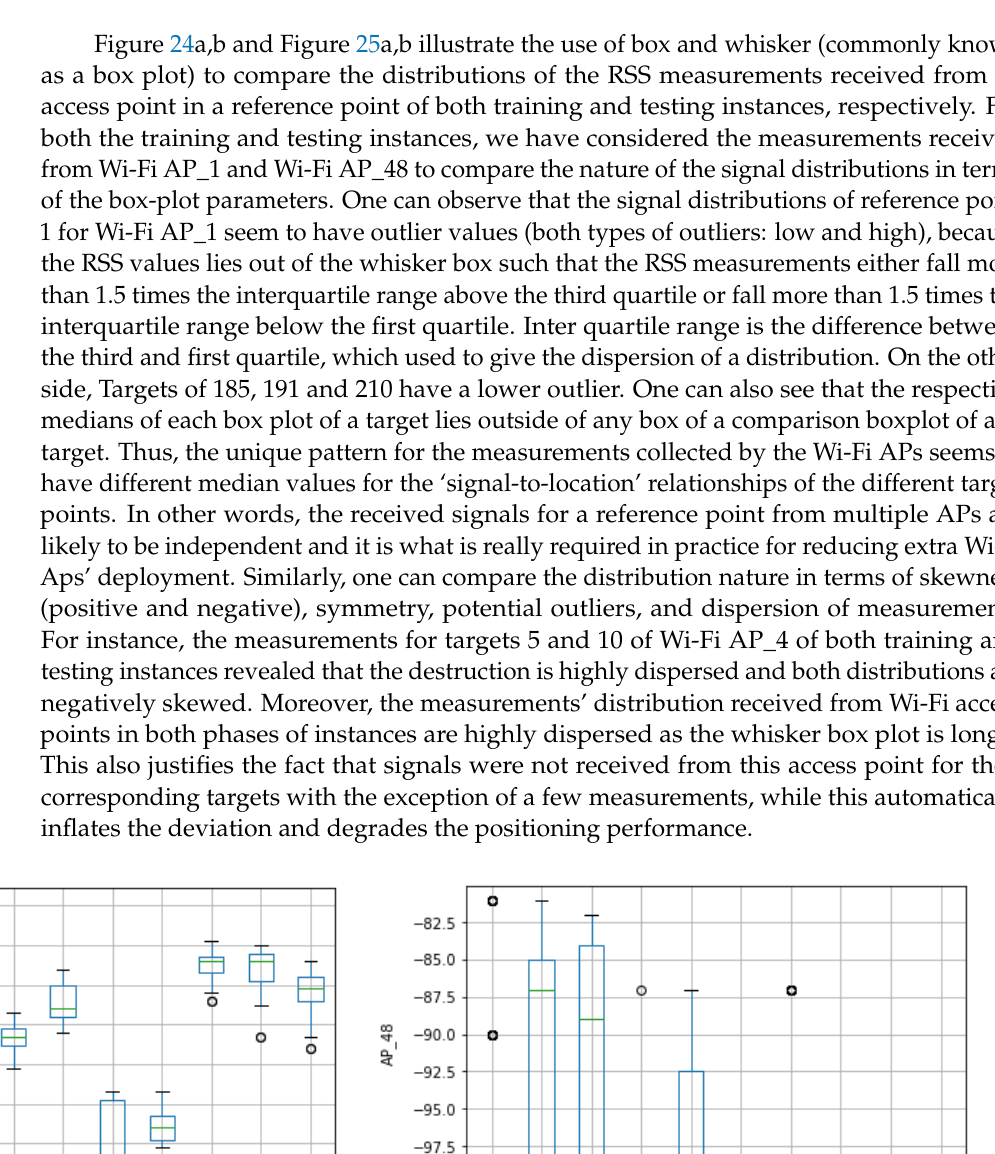
Figure 25. Distribution analysis of Wi-Fi RSS testing measurements of different APs based on box and whisker plot. The small circles found above and below the whisker box plot represents the outliers of the testing measurements received from the Wi-Fi APs of ( a ) AP_1 and ( b ) AP_48. 4.4. Analysis of Computational Complexity Figure 26 presents the computational complexity of the proposed algorithm for IPS- based RSS fingerprinting, which fuses source and target domain knowledge to enhance positioning performance in the target domain. The algorithms presented in this paper were run on a laptop with an AMD Ryzen 3 3200U CPU running at 2.60 GHz and 16 GB of RAM. Two situations of complexity—time and space—are the main determinants of an algorithm’s complexity. To assess the time complexity of the algorithms, we employed